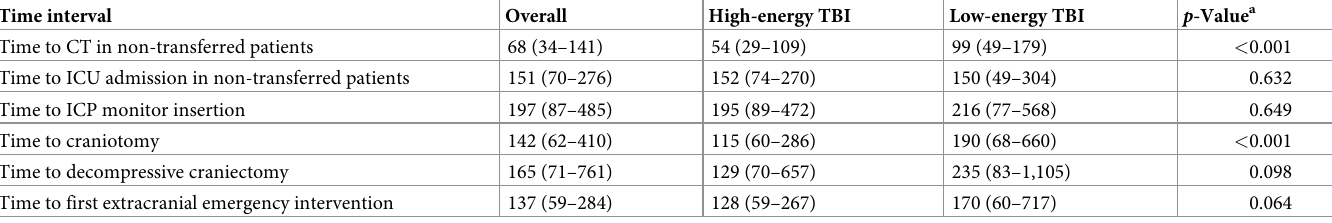
Table 3. Median (interquartile range) times (in minutes) from arrival to imaging and key emergency interventions in study hospital (21,681 patients).